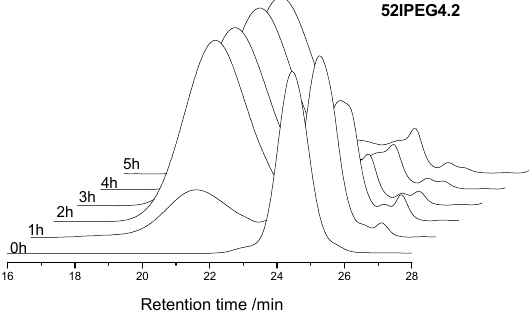
Figure 5. SEC spectra of 52IPEG4.2 for the time interval of 1 h.